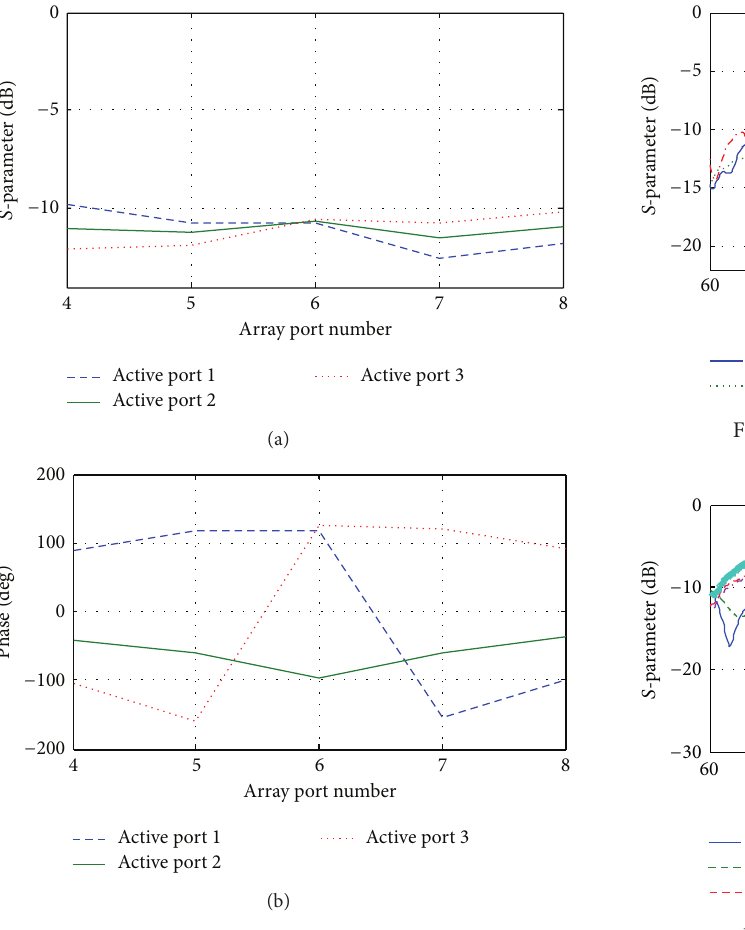
Figure 11: Crosstalk (dB) over